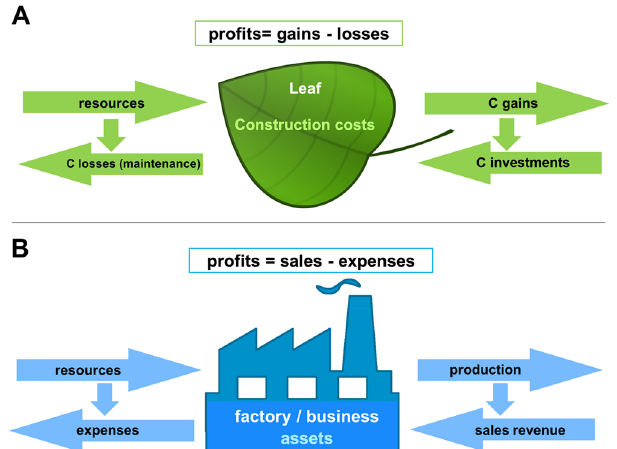
Figure 1. Scheme of general economic functioning of leaves and companies. ( A ) Leaves show similar behaviour to companies. A leaf acquires different resources (CO 2 , light, nutrients and water) to synthesize carbohydrates (C gains) which can be used for maintenance (C expenses) or stored and/or exported to be used in various ways (transport of compounds to other organs, construction of new organs, etc.) (C investments). The carbon profit of the leaf will be then the difference between the carbon gains and the carbon expenses. ( B ) A company acquires the resources (work, capital and natural resources) through financial investment in activities (expenses) to make different products that are sold, resulting in gains (sales revenue). The overall financial profit of these activities will be the difference between the sales and the